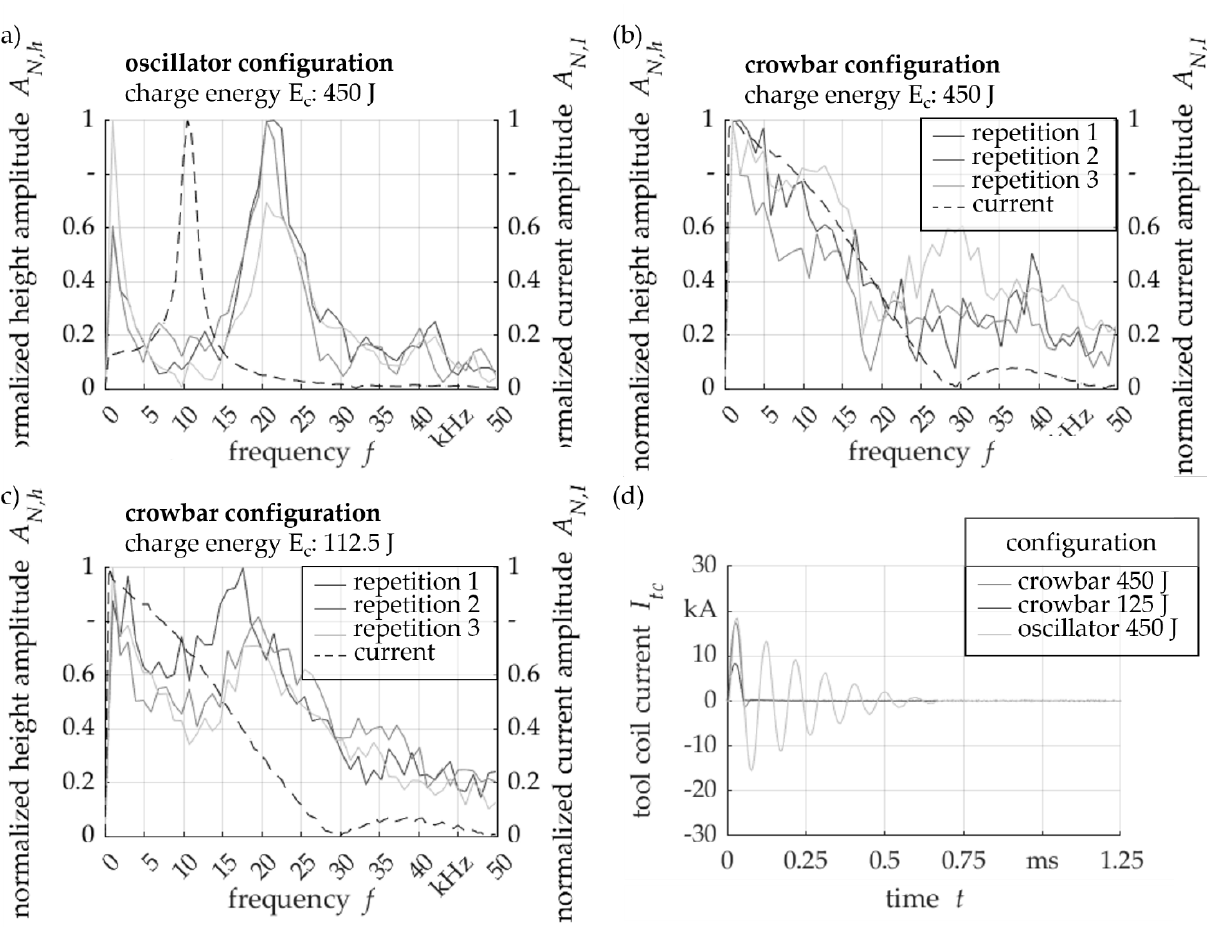
Figure 4. Forming height and tool coil current oscillations: ( a ) oscillator configuration ( E C = 450 J), ( b ) crowbar configuration ( E C = 450 J), ( c ) crowbar configuration ( E C = 112.5 J), ( d ) tool coil current in time domain.